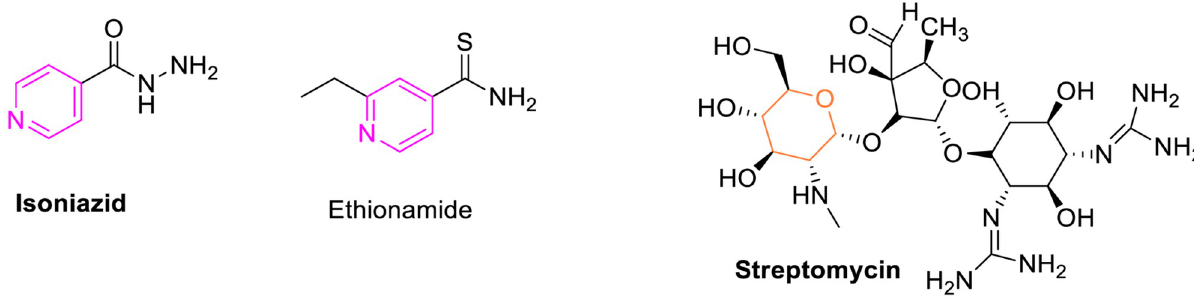
Fig 1. Structures of selected marketed antitubercular drugs containing pyridine and tetrahydropyran scaffolds.